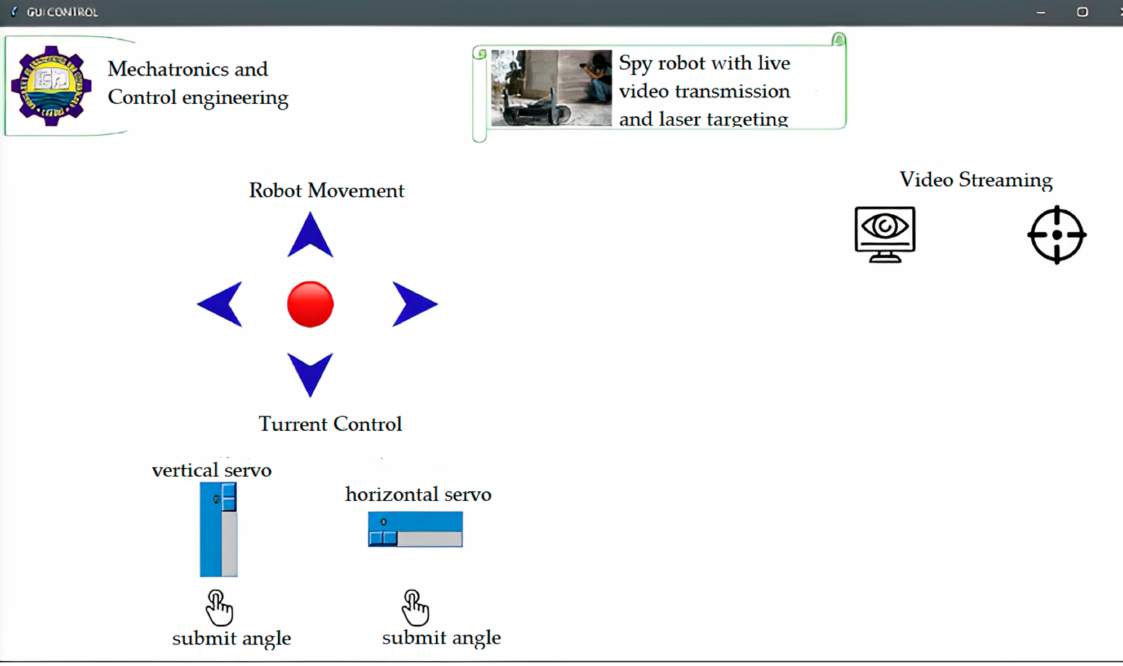
Figure 15. Python-based